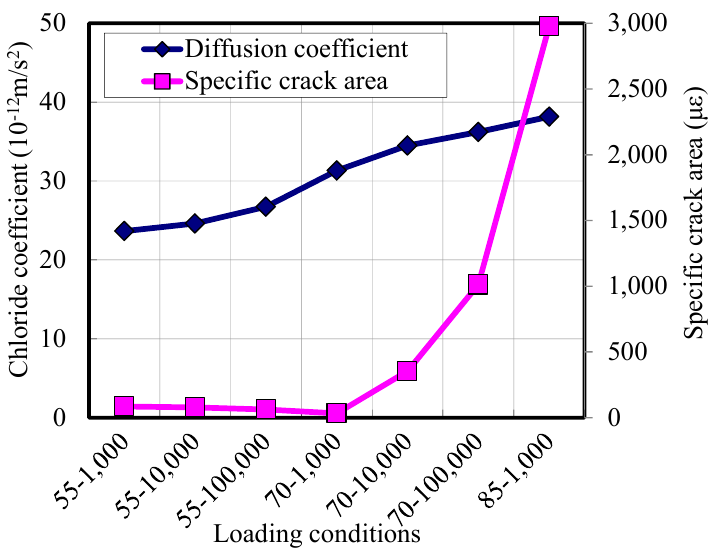
Figure 11. Chloride diffusion coefficients of damaged plain concrete specimens.